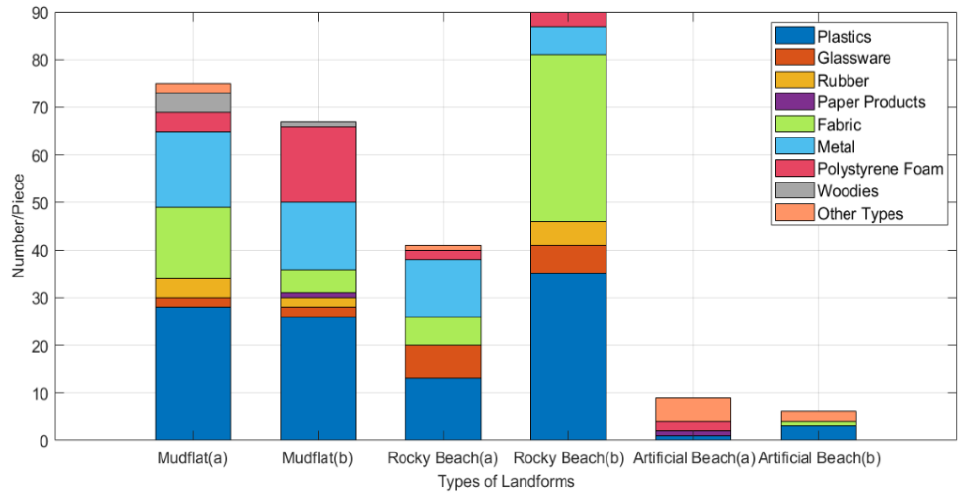
Figure 5. Classification results by types of litter from the survey samples.